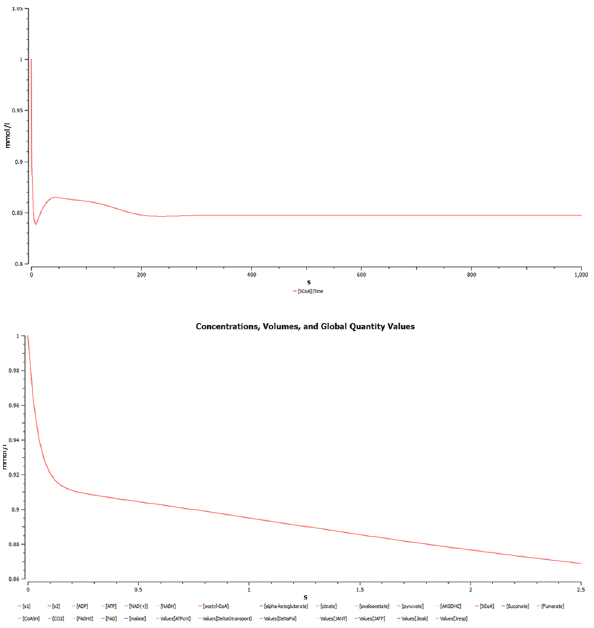
Fig 11. Correlation between NAD+, AKG and NADH. The plots of concentration changes with respect to time between NAD + (purple), AKG (blue) and NADH (yellow), this integrated plot shows that rate of change of NADH with NAD + and AKG. It clearly depicts that rate of NADH formation depends upon